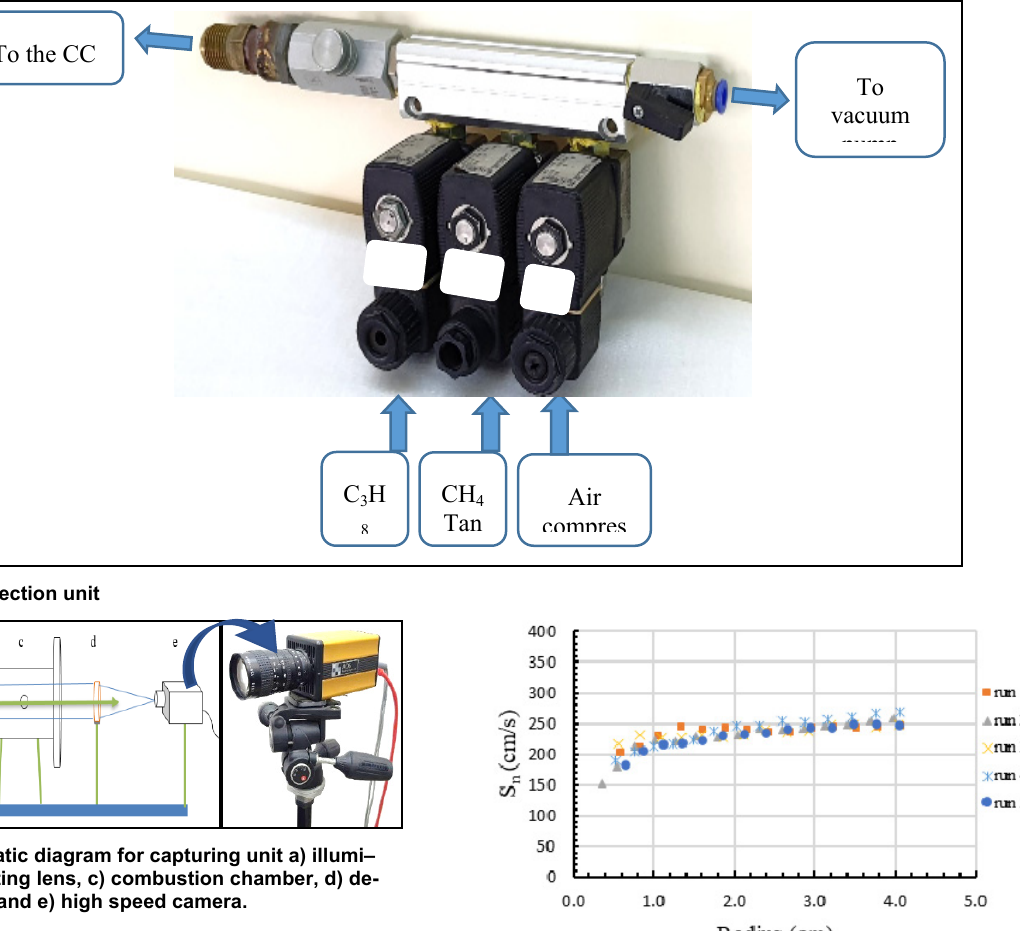
Figure 6. Stretched flame speed with flame radius for methane at T i =306 K, P i =1 bar, and Ø=1.